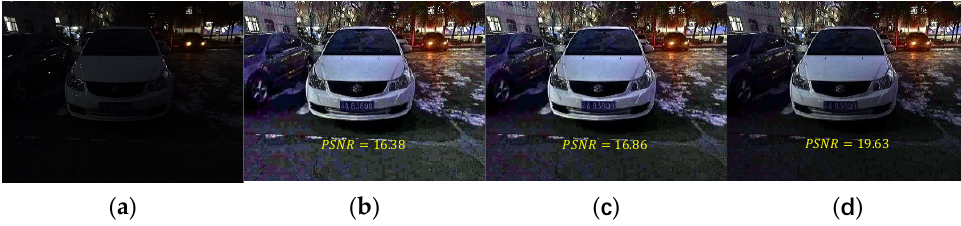
Figure 4. Selection of parameter t 0 .( a ) original image. The enhancement result with ( b ) t 0 not to be introduced, ( c ) t 0 = 0.1, and ( d ) t 0 = 0.2.